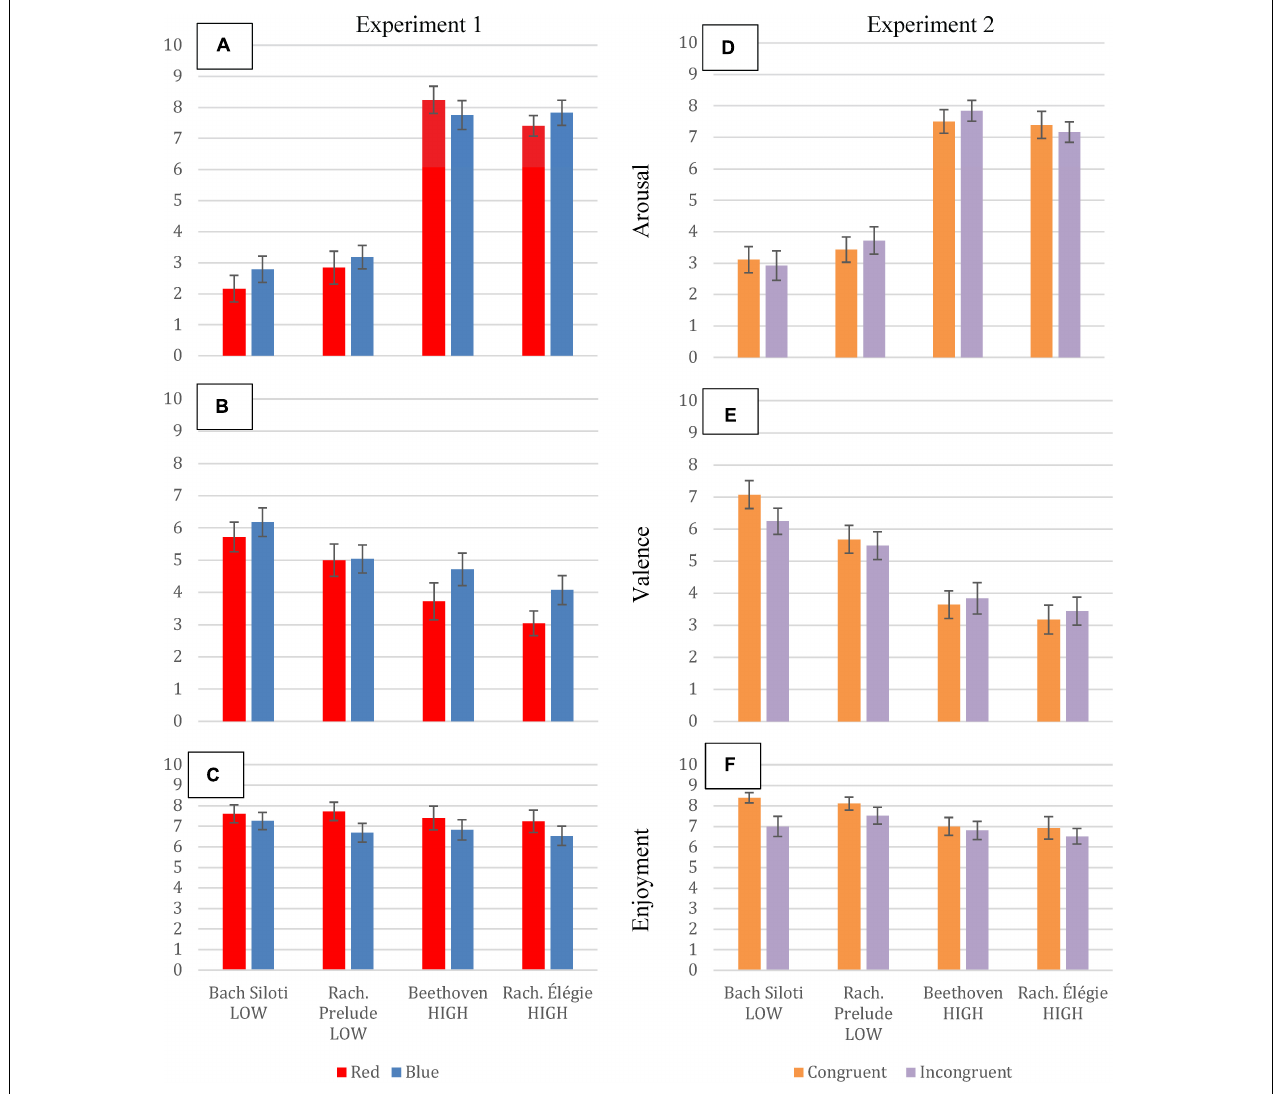
FIGURE 1 | Error bar plots of mean arousal, valence and enjoyment ratings (respectively) in Experiment 1 (A–C) and Experiment 2 (D–F) . Error bars = ± ±